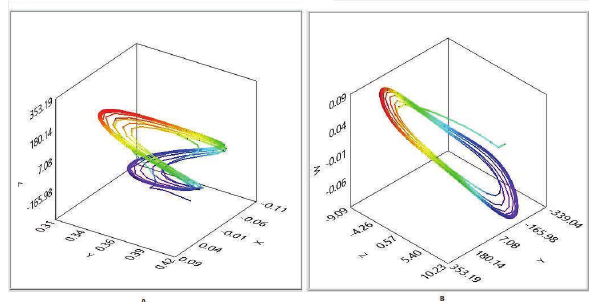
Fig. 2: 3D state portraits of the fractional order induction motor (A-XYZ Plane, B-YZW